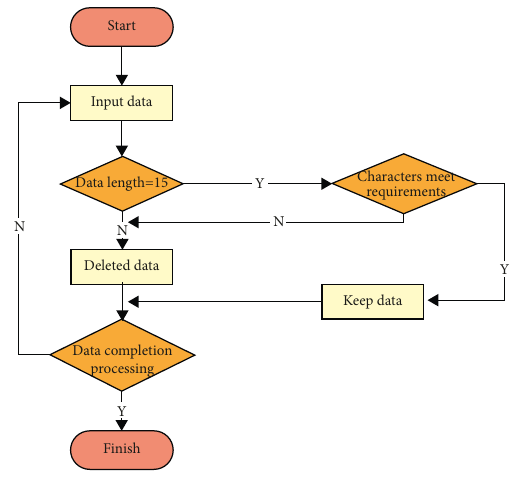
Figure 4: Data integration